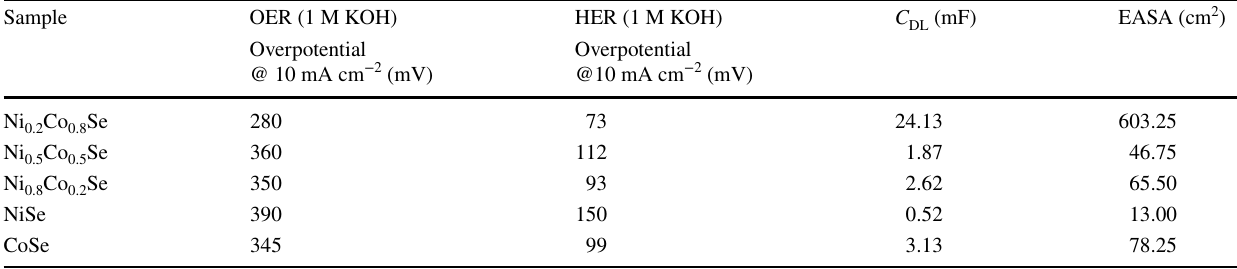
Table 1 OER and HER activity for the Ni x Co 1− x Se series, including the results of OER and HER tests in 1 M KOH, as well as the electrochem‑ ical properties